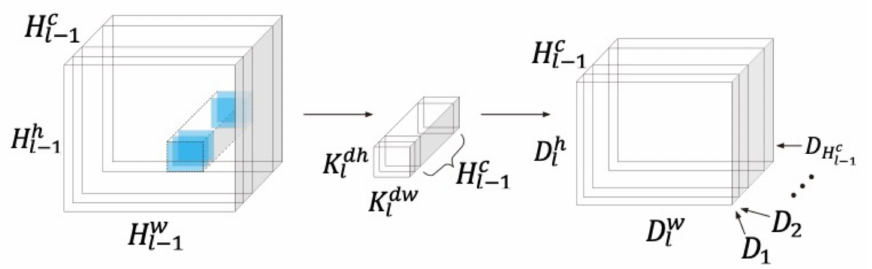
Figure 2. The first step of the depthwise separable convolution: learning spatial information, using H c different kernels K l , applied to each H l − 1 l − 1